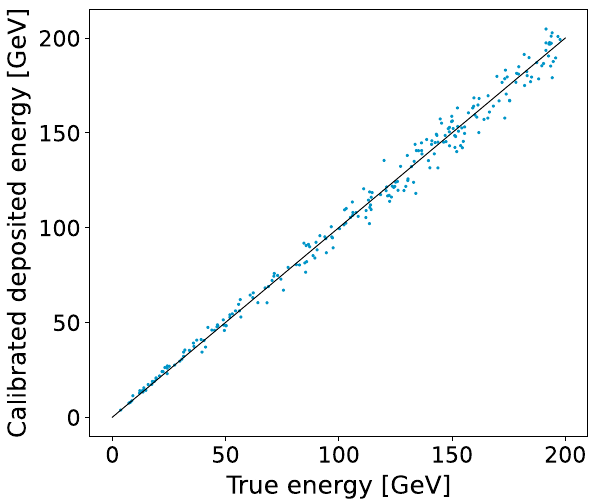
Fig. 4 A scatter plot showing calibrated deposited energy versus true energy of photons shot between 1.8 < η <